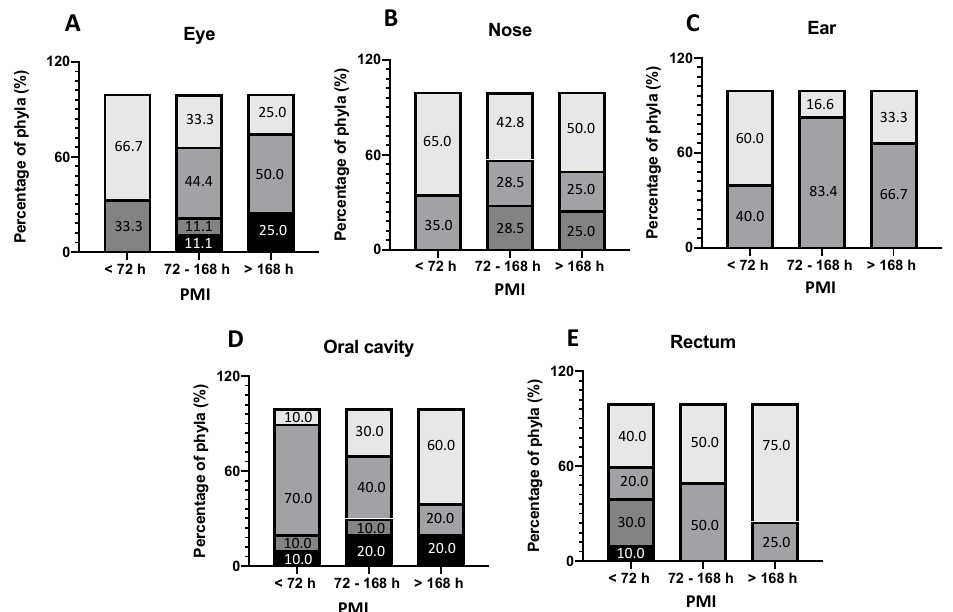
Figure 2. The distribution of genera among the four internal anatomical sites: A) heart; B) brain; C) spleen and D) liver.